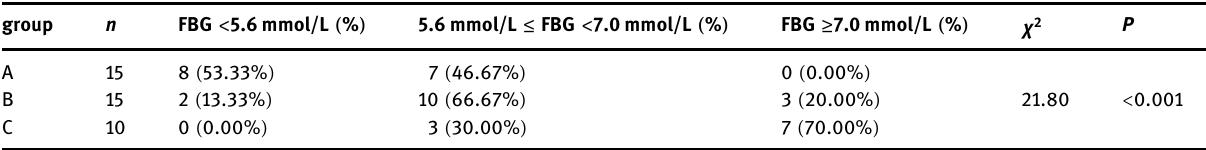
Table 2: The proportion of abnormal glucose metabolism at di ff erent 25 ( OH ) D levels